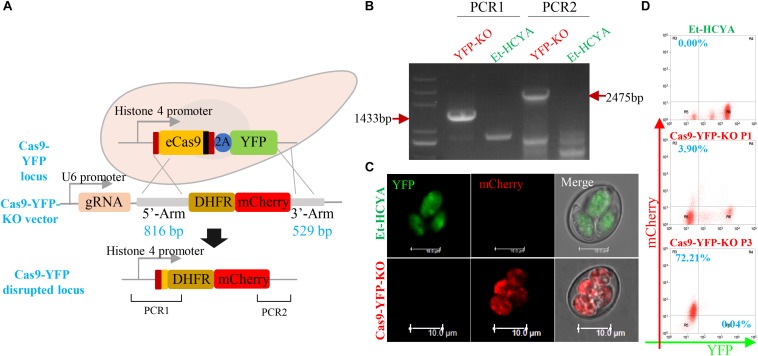
CRISPR/Cas9-directed YFP gene disruption in transgenic EtHCYA. (A) Schematics showing CRISPR/Cas9-mediated disruption of endogenous cas9-yfp locus by transfecting Cas9-YFP-KO vector. This vector contains a gRNA targeting yfp driven by EtU6 promoter, and DHFR:mCherry coding sequence (without promoter) flanked by 5′ and 3′ homologous regions. Endogenous cas9-yfp locus disruption was determined by PCR (B) and fluorescent microscopy (C). The specific bands in Cas9-YFP-KO parasites were marked with red arrows. (D) Cas9 editing efficiency detected by flow cytometry. P1: first generation of progeny oocysts post-transfection; P3: third generation post-transfection.